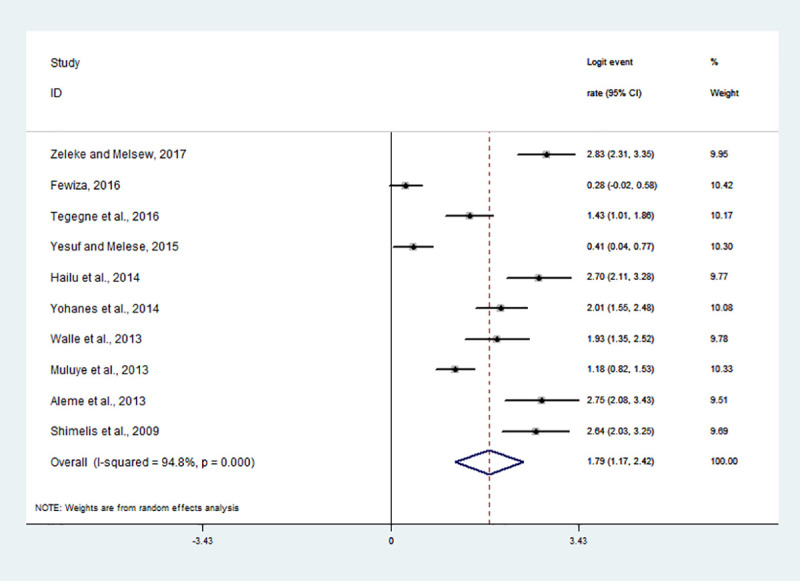
Forest plot of the logit event rate estimate (lp) in HIV infected individuals.